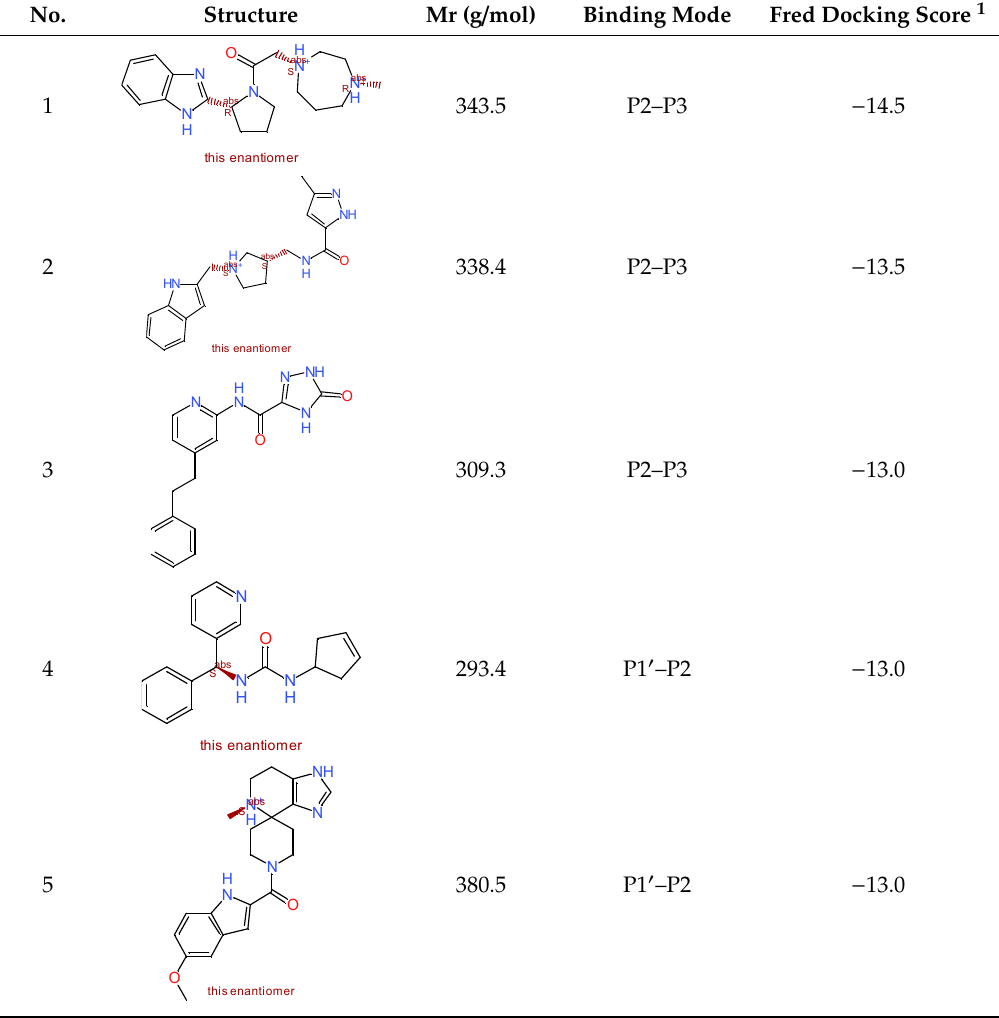
Table 1. Identified top-scoring compounds in the ensemble docking VS on the SARS-CoV-2 main protease (for the complete list see Table S5 in the Supporting Information).